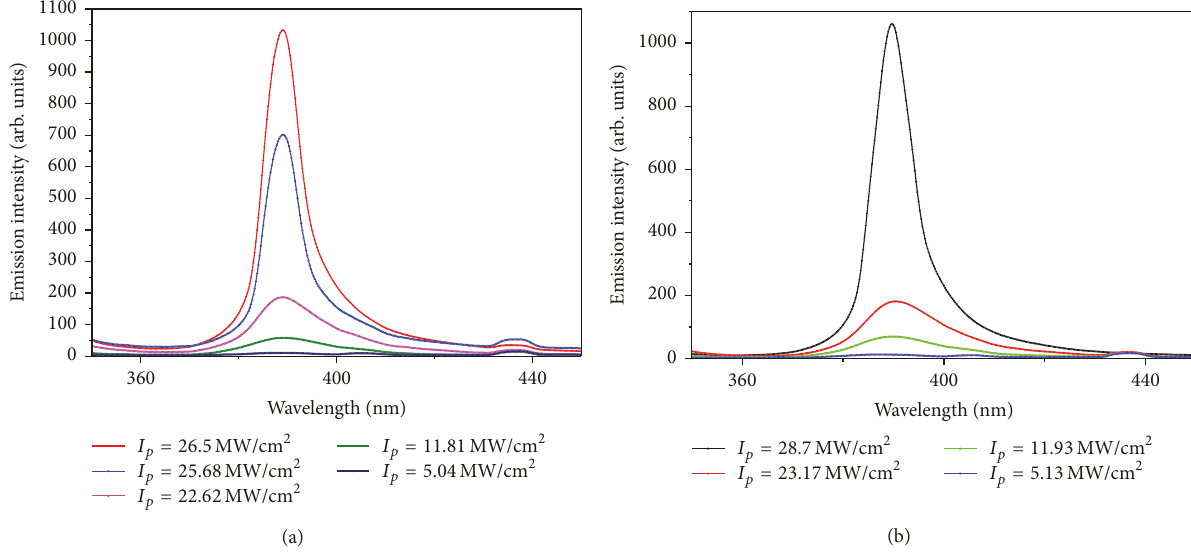
Figure 6: Spectra emitted from (a) S1 and (b) S2 at different pump intensities.